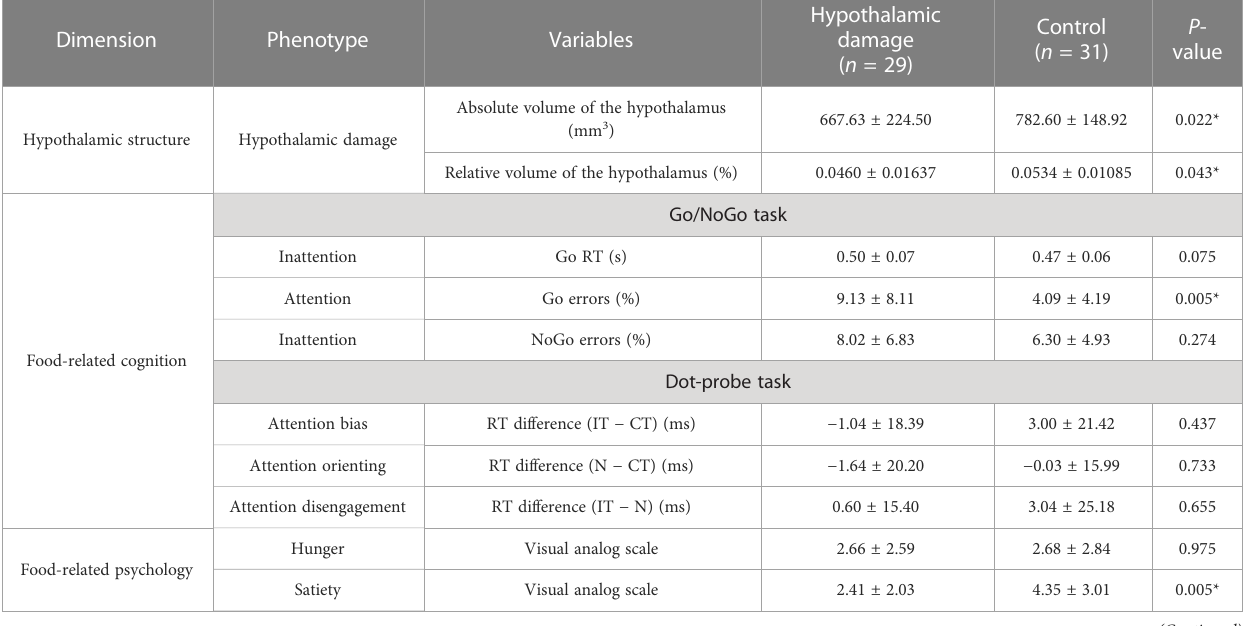
TABLE 2 Neuroimaging, psychological, cognitive, and clinical phenotyping of the hypothalamic damage group. Dimension Phenotype Variables